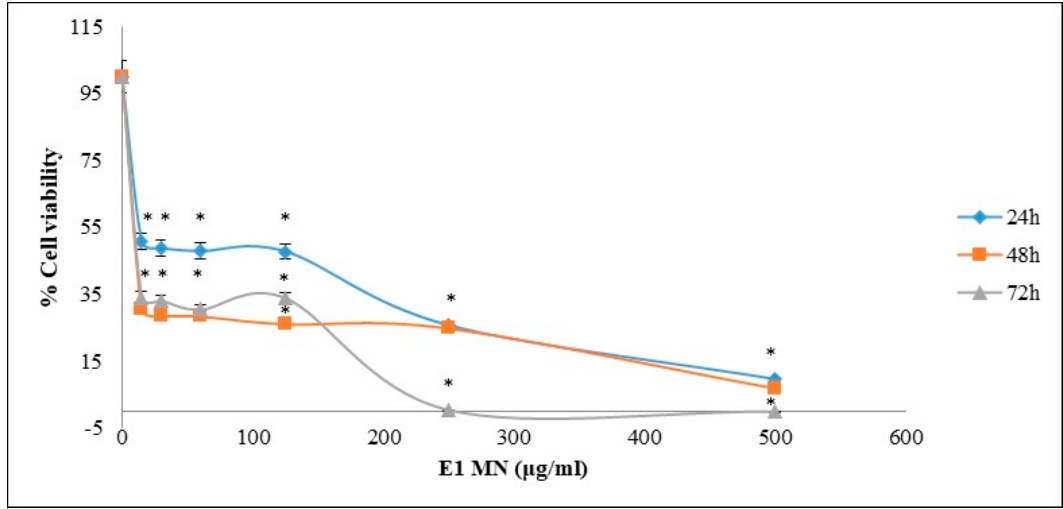
Figure 4. Dose–effect survival plots for liposomes containing NMGE against human breast cancer MCF-7 cell growth. Cell viability was estimated via XTT assay (each point represents mean ± sd of at least six replicate wells). * p < 0.05.